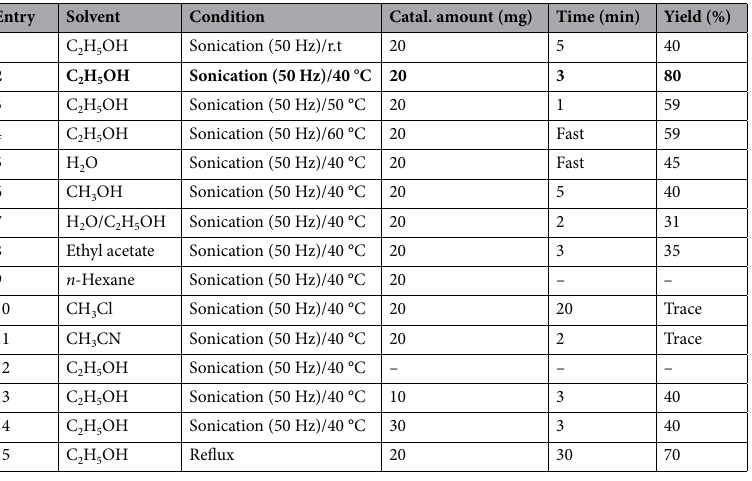
Table 3. Optimization of the reaction conditions for the synthesis of pyranopyrazoles. Significant values are in bold.